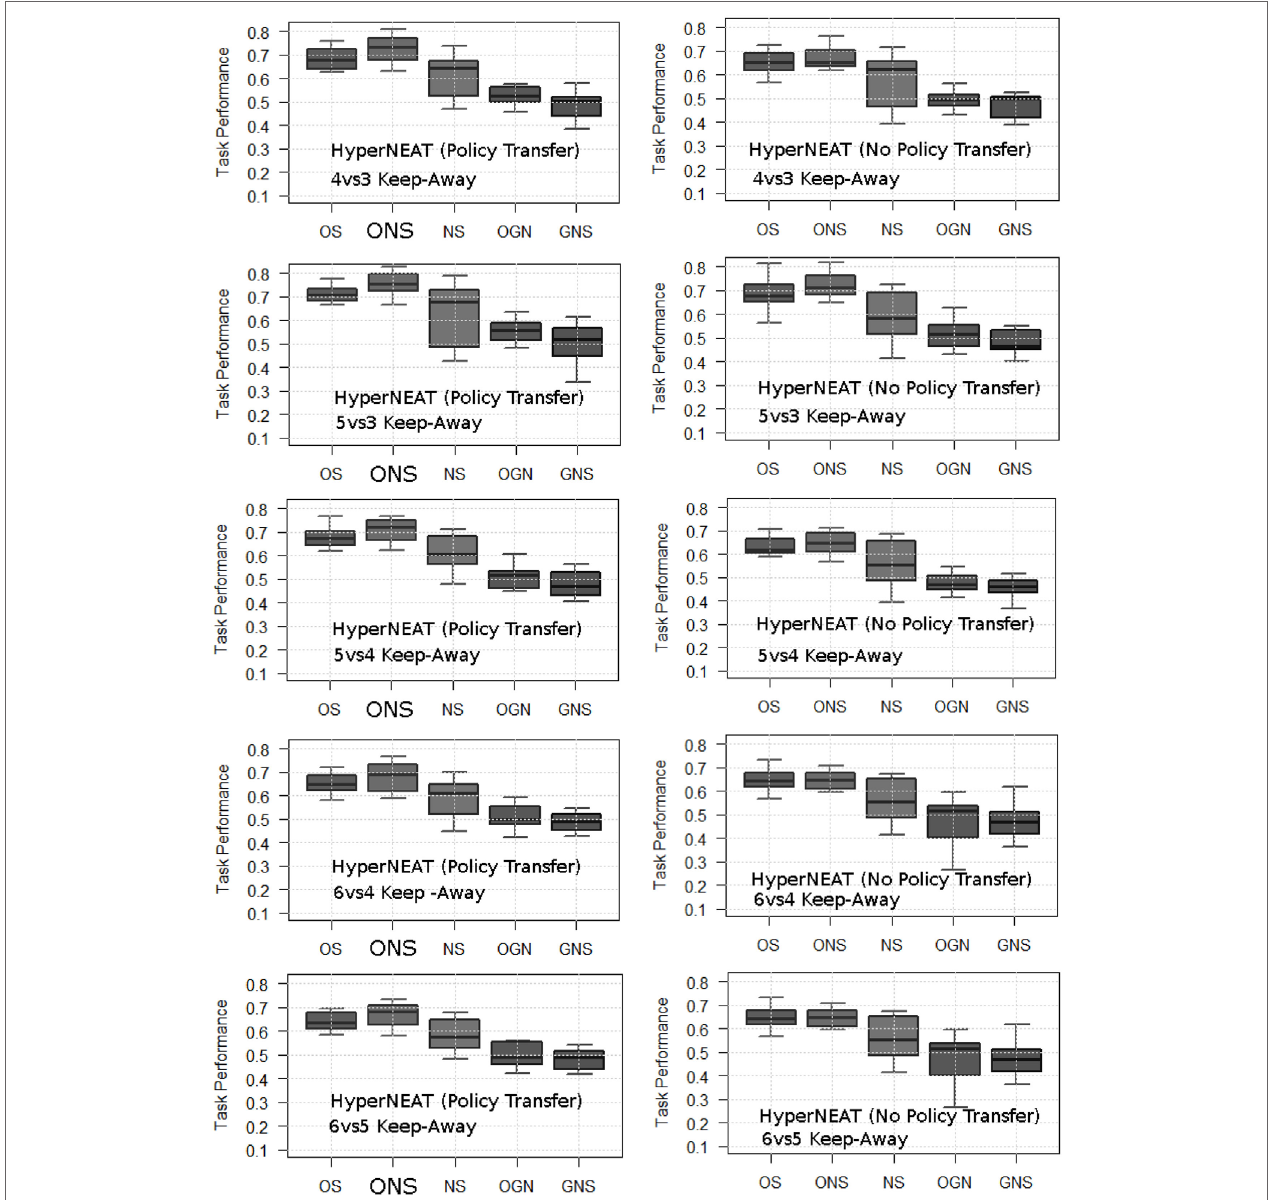
FigUre 2 | Average normalized maximum task performance for HyperNEAT variants with (left column) and without (right column) policy transfer in each target task. OS, objective-based; NS, Novelty Search; ONS, Objective-Novelty hybrid; GNS, Genotypic novelty search; OGN, Objective-GNS hybrid. Averages are over 20 runs. Bold Ons indicates that the ONS variant yields a higher average task performance (with statistical significance, Mann–Whitney U test, p < 0.05) for all tasks (given policy transfer). This significant difference holds for ONS over other variants (with policy transfer) and between ONS (with policy transfer) and all variants (without policy